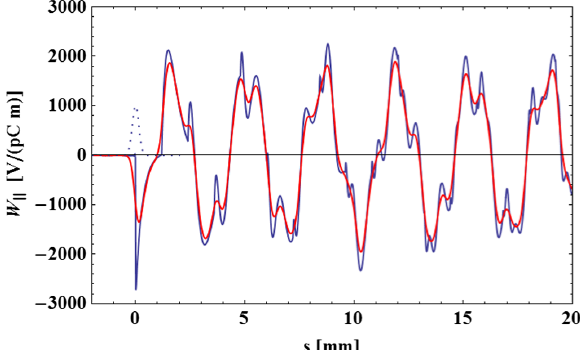
FIG. 14. Real (red, dashed line) and imaginary (black, solid line) components of the longitudinal impedance of a perfectly conducting waveguide with a thin dielectric layer: a 1 ¼ 2 mm, d ¼ 2 μ m, ε 0 10 ; and ε 00 0 . 1 . 1 ¼ 1 ¼